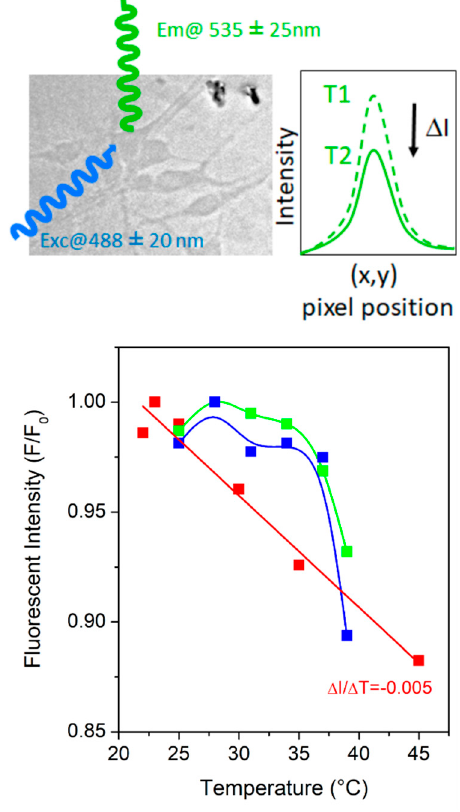
Figure 4. Temperature dependence of the PL of Yb 3+ ,Er 3+ -doped α -La(IO 3 ) 3 nanocrystals monitored with an epifluorescent microscope (Olympus BX51), without and with neurons (red and green/blue dots, respectively). The intensity per pixel is collected with a ×60 water-immersion objective, as a function of the substrate temperature adjusted with a Linkam controller. A FlTC-filter cube enables to select the incident illumination (xenon lamp) at the nanocrystal excitation wavelength λ exc = 488 ± 20 nm and to collect their emission around λ em = 535 ± 25 nm. A high-pass dichroic mirror at λ dic = 510 nm suppresses the contribution of the incident photons on the recorded signals. The signal is monitored with sCMOS Andor Zhyla 5.5 camera at a constant exposure time 50 ms.